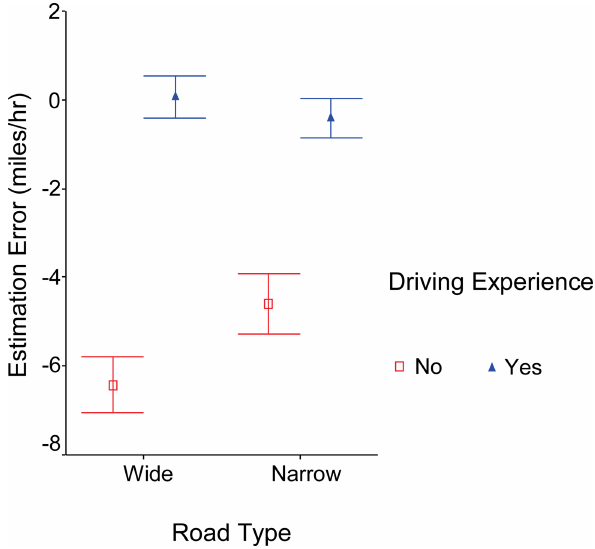
Fig 4. Effects of gender and driving experienceon speed estimation. (a) Females had greater estimationerrors than males with the greatest differencesat the highestand lowest speed groups. (b) Participants without driving experience increasingly underestimated speed as speedincreasedwhereasparticipantswith driving experience only underestimated the highest speeds.